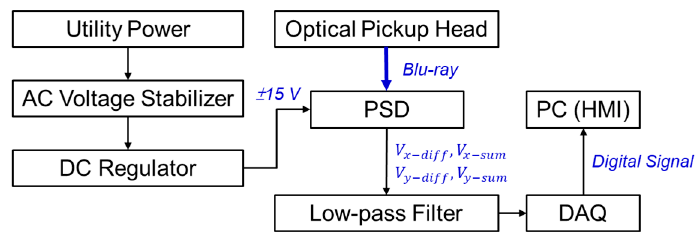
Figure 1. Architecture of the TCP − OMS in this study.